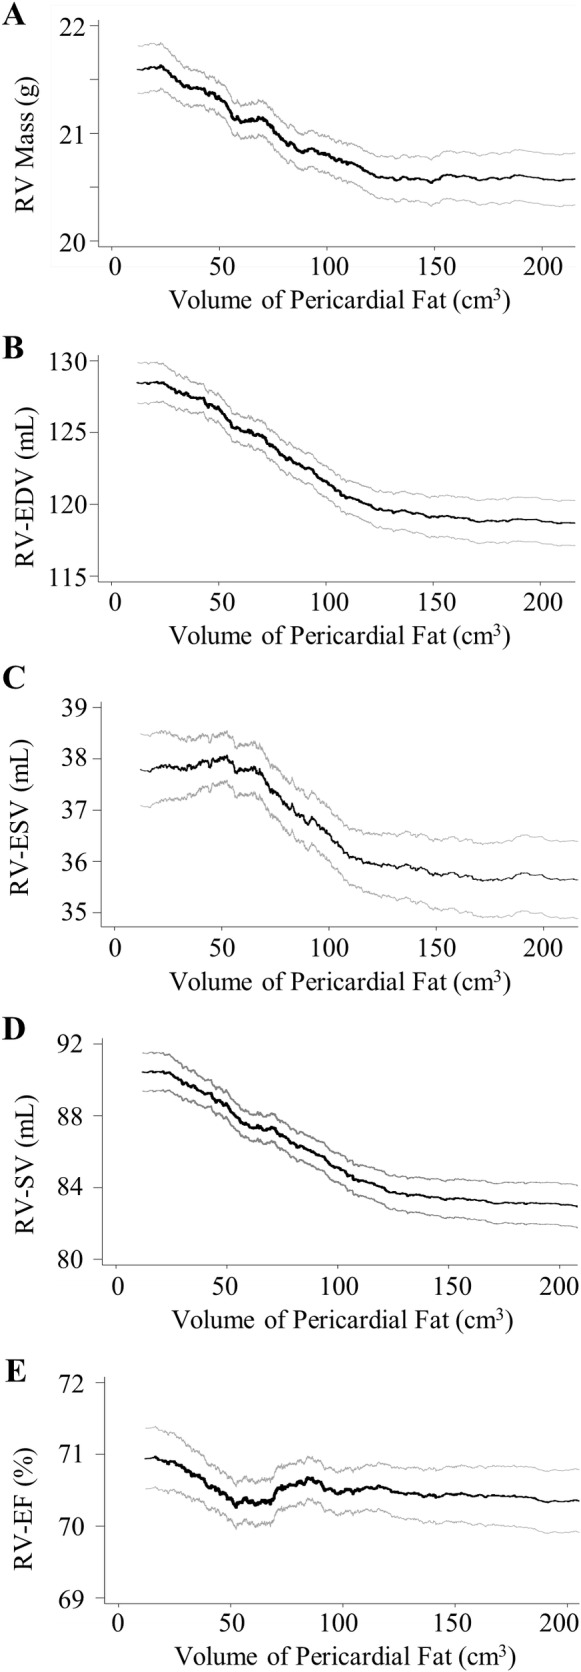
Multivariable nonparametric smoothed relationship between pericardial fat volume in cm3 and right ventricular (RV) parameters with adjustment for age, gender, race, height, weight, study site, education level, exercise habits, and smoking status including pack years smoked (black line).Gray lines represent 95% Confidence intervals. The relationship between pericardial fat and (A) RV mass, (B) RV end diastolic volume (EDV), (C) RV end systolic volume, (D) RV stroke volume (SV), (E) ejection fraction (EF).